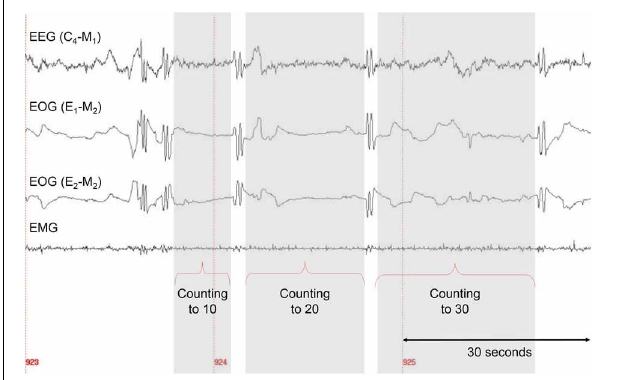
FIGURE 2 | A sample of one correctly signaled lucid dream for the counting task. Five LRLR eye signals are depicted. The interval between two LRLR eye signals corresponds to the counting interval (gray area).